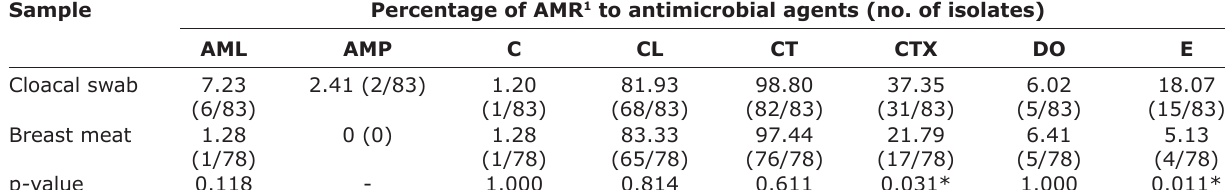
Table-2: Phenotypic antimicrobial-resistant Enterococcus isolated from chickens at local slaughterhouses in Nakhon Ratchasima Province, Thailand.